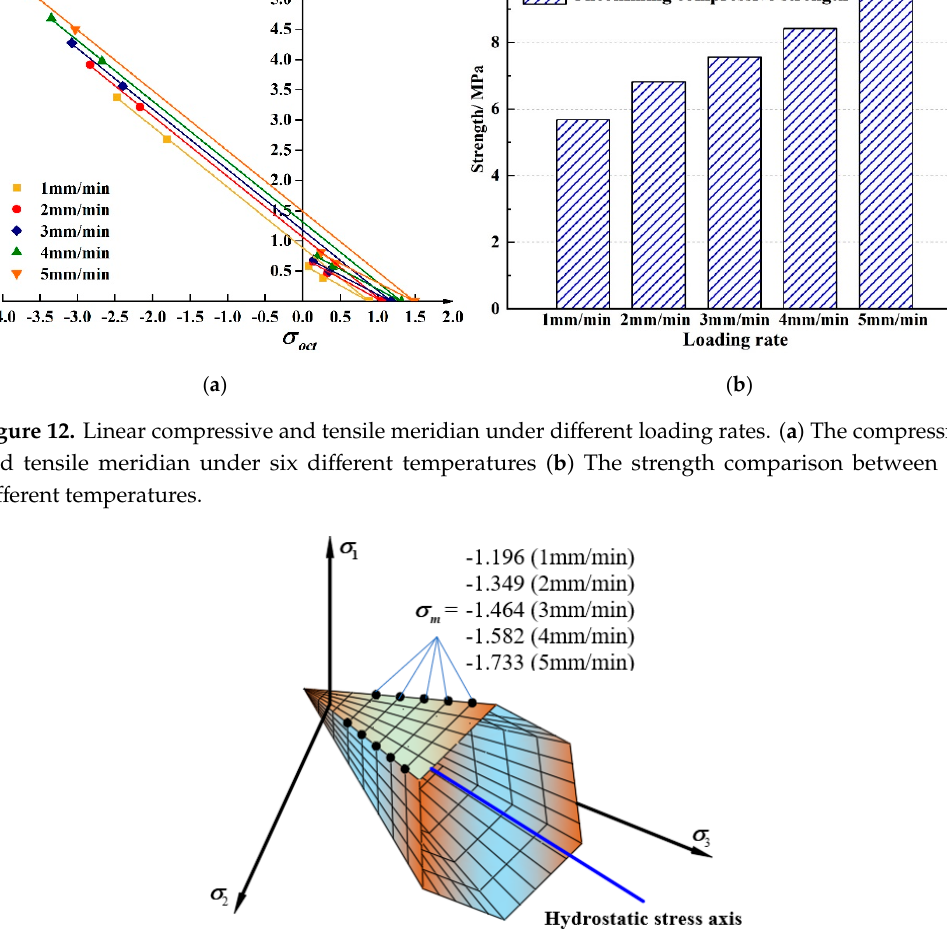
Figure 13. Linear failure envelope in π plane under different loading rates.